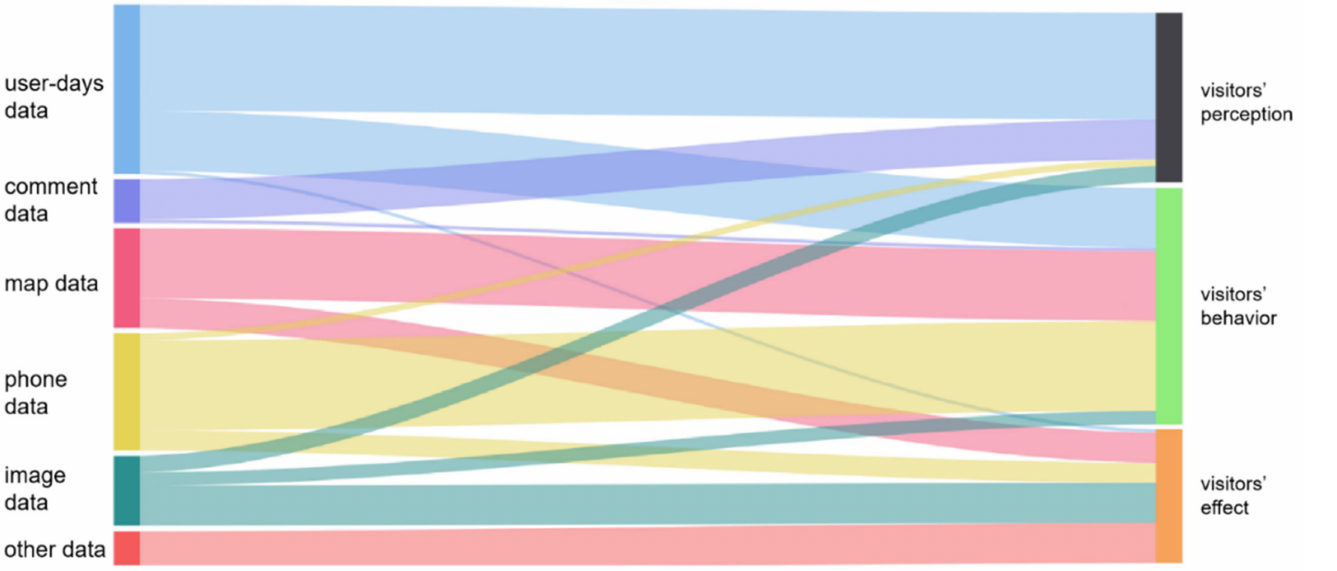
Figure 5. A sankey diagram illustrating the relations among different types of big data and research